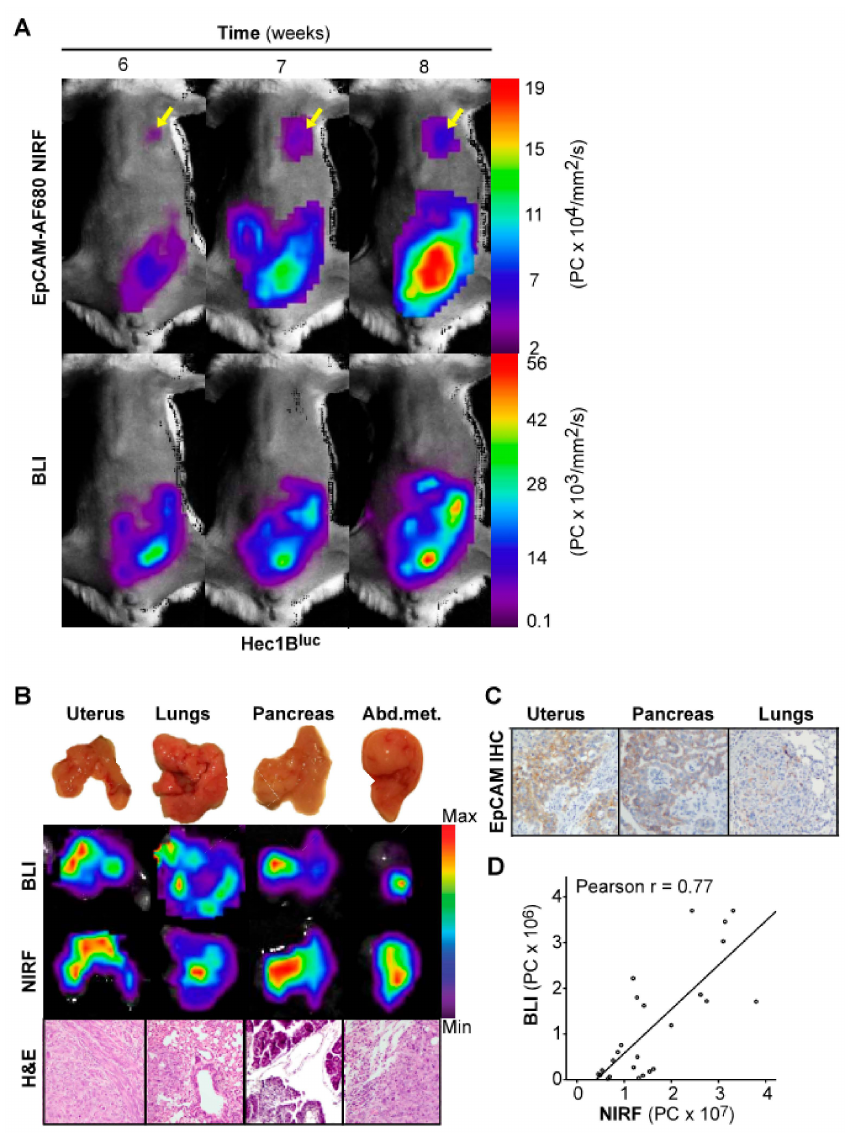
Figure 4. Optical imaging of tumor growth in an orthotopic Hec1B luc + xenograft model. In vivo BLI and EpCAM-AF680 NIRF imaging of primary tumor growth in mice orthotopically implanted with Hec1B luc + cells. NIRF imaging enabled detection of metastatic lesions in the lung (arrows), which were not evident on BLI in vivo ( A ). Macroscopic images of organs harvested during necropsy ( B , upper panel) and corresponding ex vivo BLI and EpCAM-AF680 NIRF images ( B , middle panels). Tumor cells are demonstrated in H&E stained sections (20x magnification) ( B , lower panel). Positive EpCAM expression in uterine tumor and metastases is demonstrated by IHC ( C ). Correlation plot of in vivo NIRF and bioluminescent signal in all mice included in the cell line-based models ( D ).